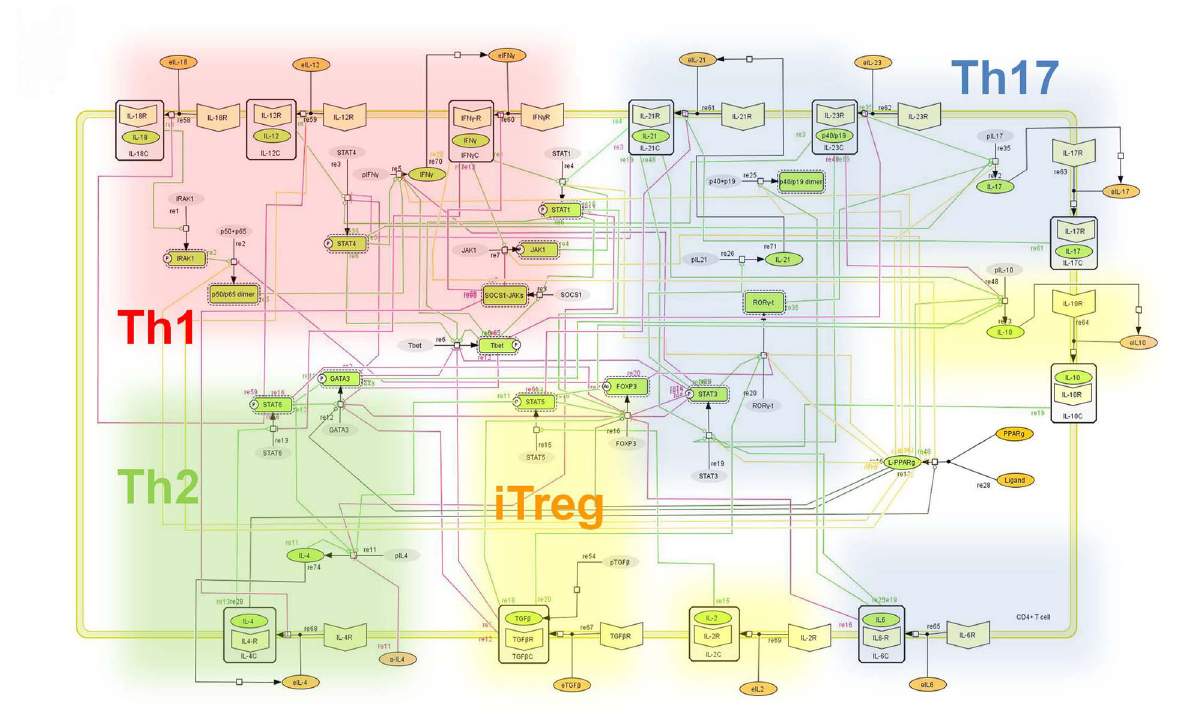
Figure 1. Network model illustrating the complex intracellular signaling pathways and transcriptional factors controlling the CD4 + T cell differentiation process. The signaling network illustrates network topologies associated with differentiation towards T helper (Th)1 (red shadow), Th2 (green shadow), Th17 (blue shadow) and induced regulatory T cells (iTreg, yellow shadow). The network is provided in Systems Biology Markup Language-compliant format.